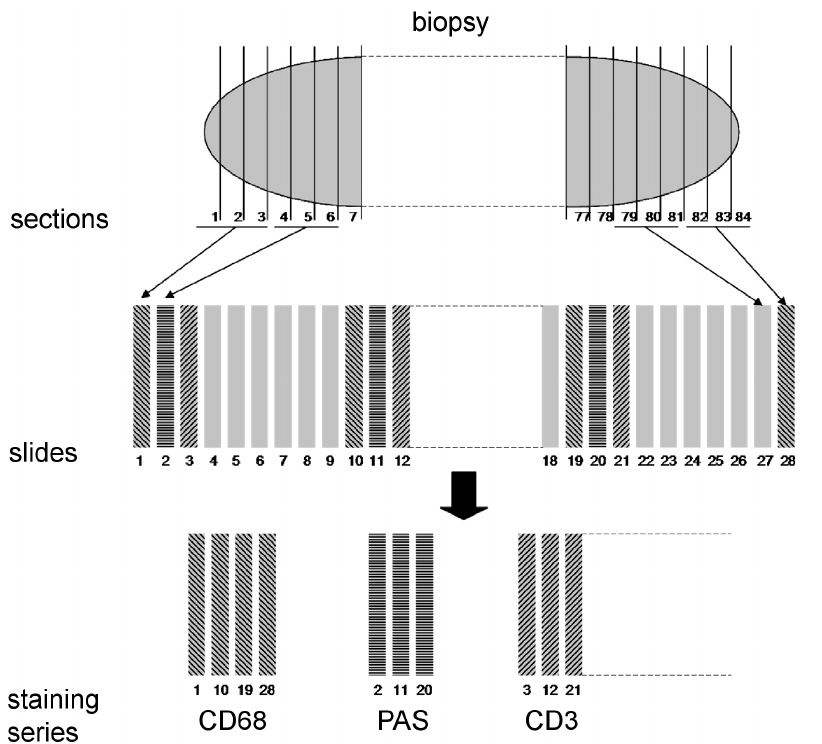
Figure 1. Schematic SUR sampling of the sections of a biopsy. After exhaustive sectioning, every three sections were mounted on numbered glass slides (1 to 28 in this example). With a random outset between the 1 st and the 9 th slide, nine slide samples, each consisting of every 9 th glass slide, were collected and stained.